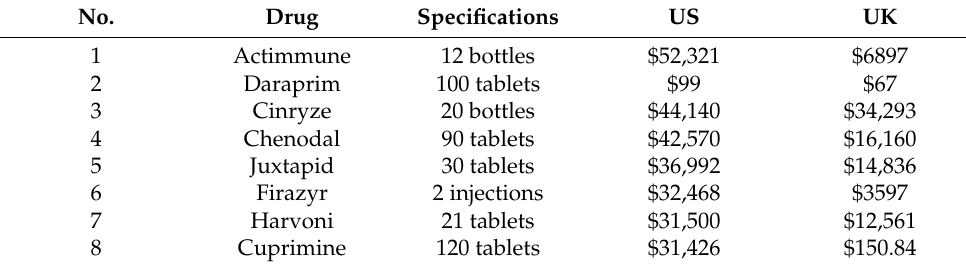
Table 1. Comparison of the prices of several popular drugs in the UK and US. No. Drug Specifications US UK 1 Actimmune 12 bottles $52,321 $6897 2 Daraprim 100 tablets $99 $67 Cinryze 20 bottles $44,140